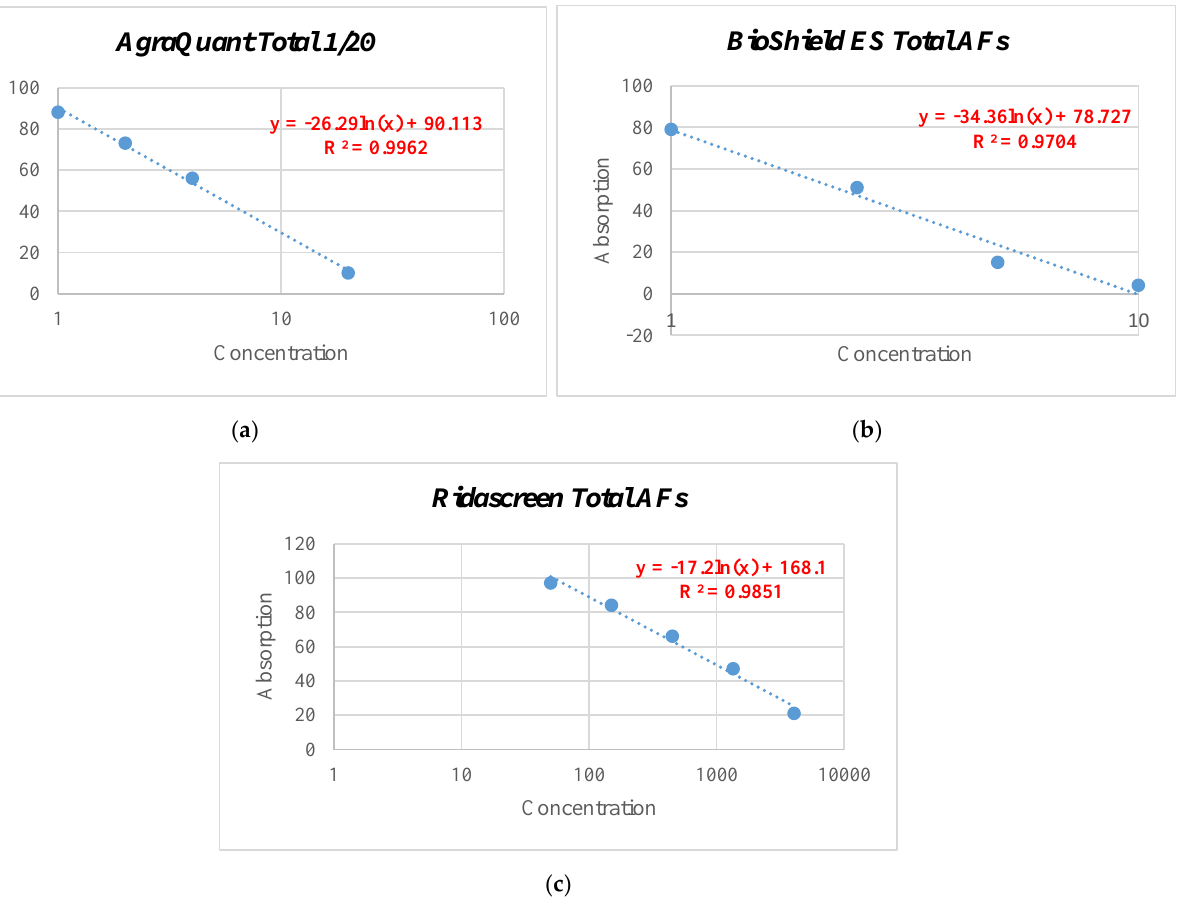
Figure 1. Reference curves of the three (ELISA) kits AgraQuant Total (a), BioShield ES Total (b) and Ridascreen Total (c) where the straight lines are linear regressions of the absorbance values.